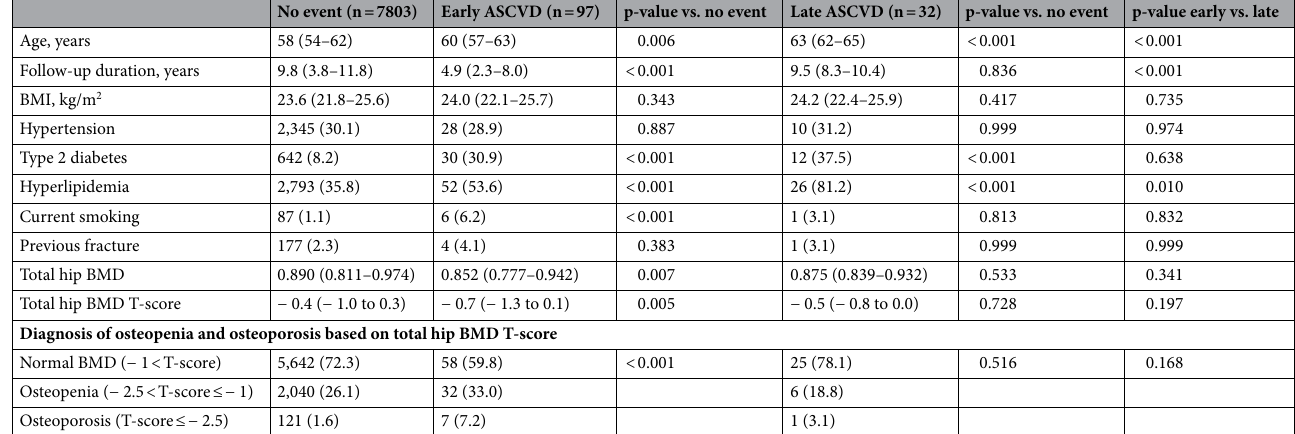
Table 1. Baseline characteristics. Data are presented as the median (interquartile range) for continuous variables and number (percentage) for categorical variables. ASCVD atherosclerotic cardiovascular disease, BMD bone mineral density, BMI body mass index.